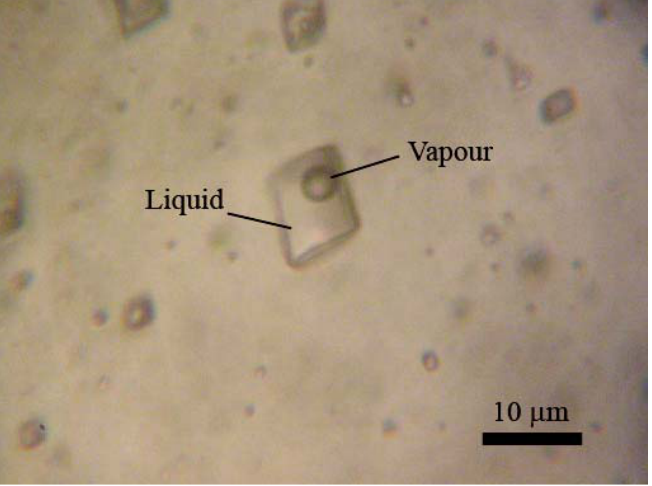
Figure 9. Photomicrograph of a typical aqueous fluid inclusion in cloudy calcite from Ersmarksberget.